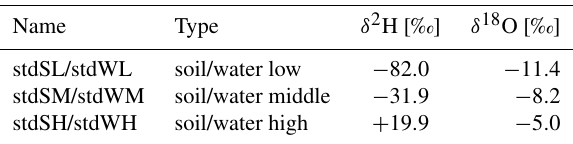
Table 3. Soil and water standards for in situ stable water isotope measurements.